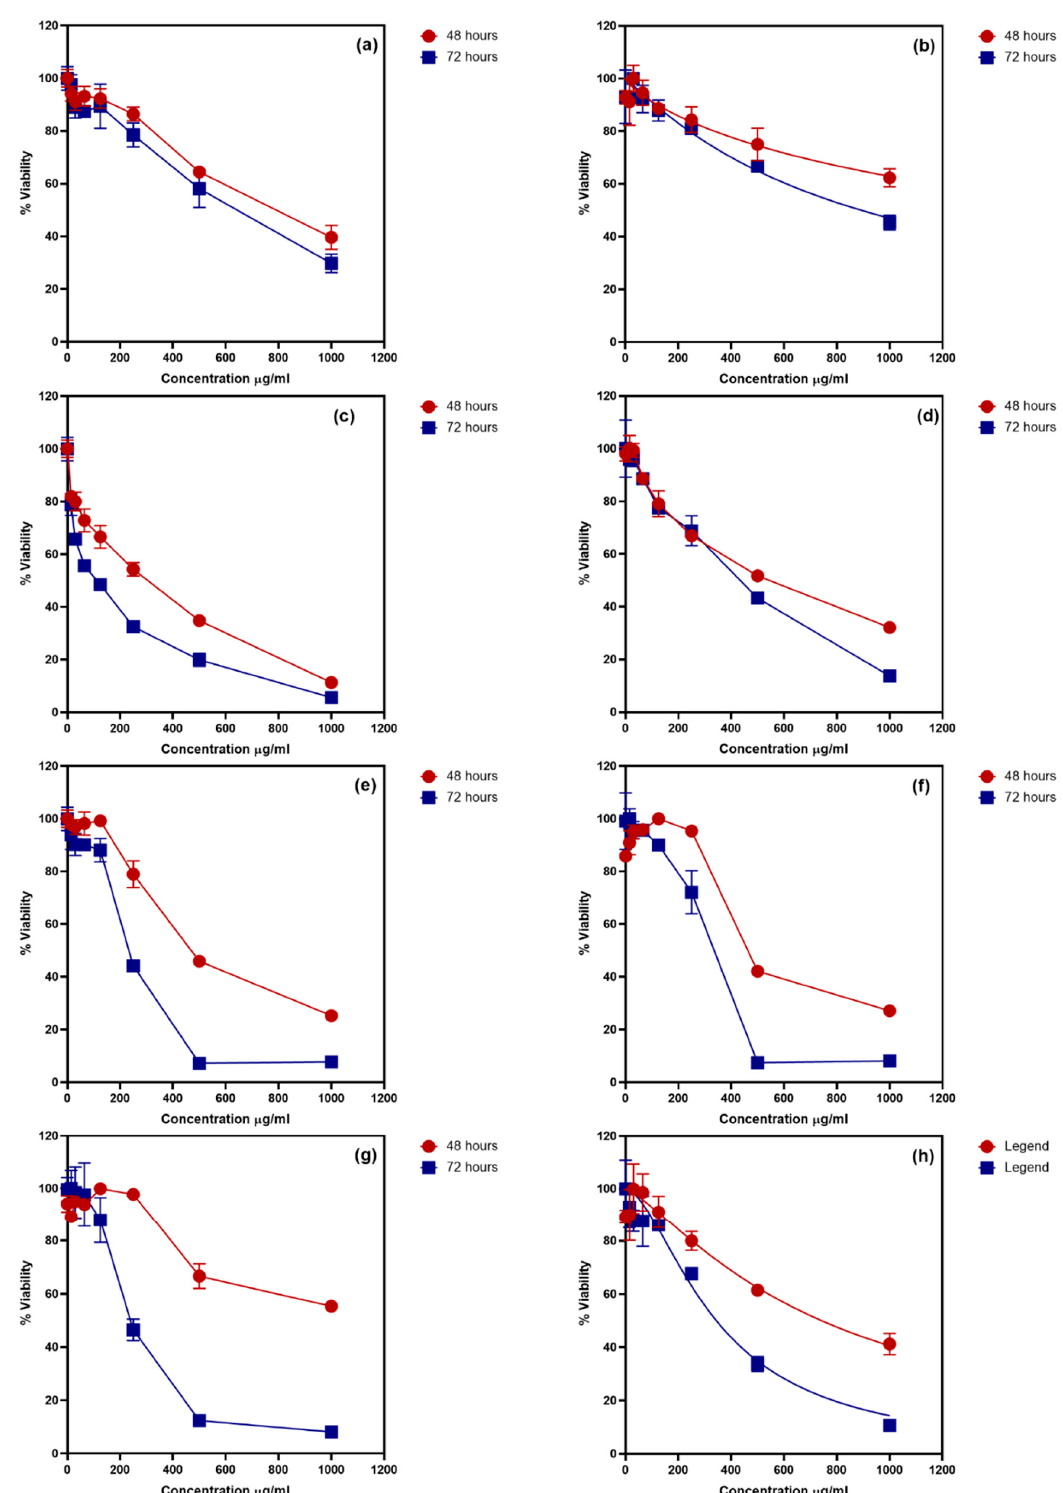
Figure 2. Graphical representation of cell viability percentage with M. peregrina leaves extracts on MCF-7 and Caco-2 cells with 48 and 72 h incubation: ( a )—Hexane extract in MCF-7; ( b )—hexane extract in Caco-2; ( c )—chloroform extract in MCF-7; ( d )—chloroform extract in Caco-2; ( e )—acetone extract in MCF-7; ( f )—acetone extract in Caco-2; ( g )—methanol extract in MCF-7 and ( h )—methanol extract in Caco-2. Values are expressed as mean ± SD of three experiments ( p -value relative to control group: p < 0.05).